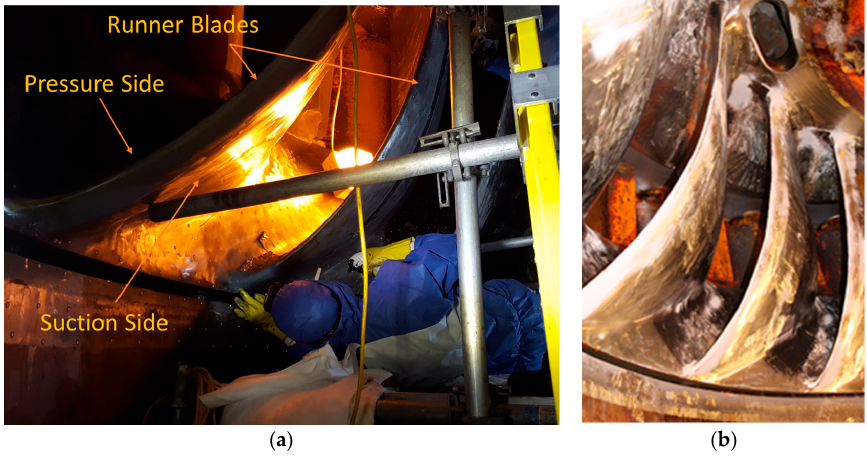
Figure 1. Pictures of the Francis turbine runner studied. ( a ) Picture during the installation of the strain gauges in the runner; ( b ) detail of the runner blades.